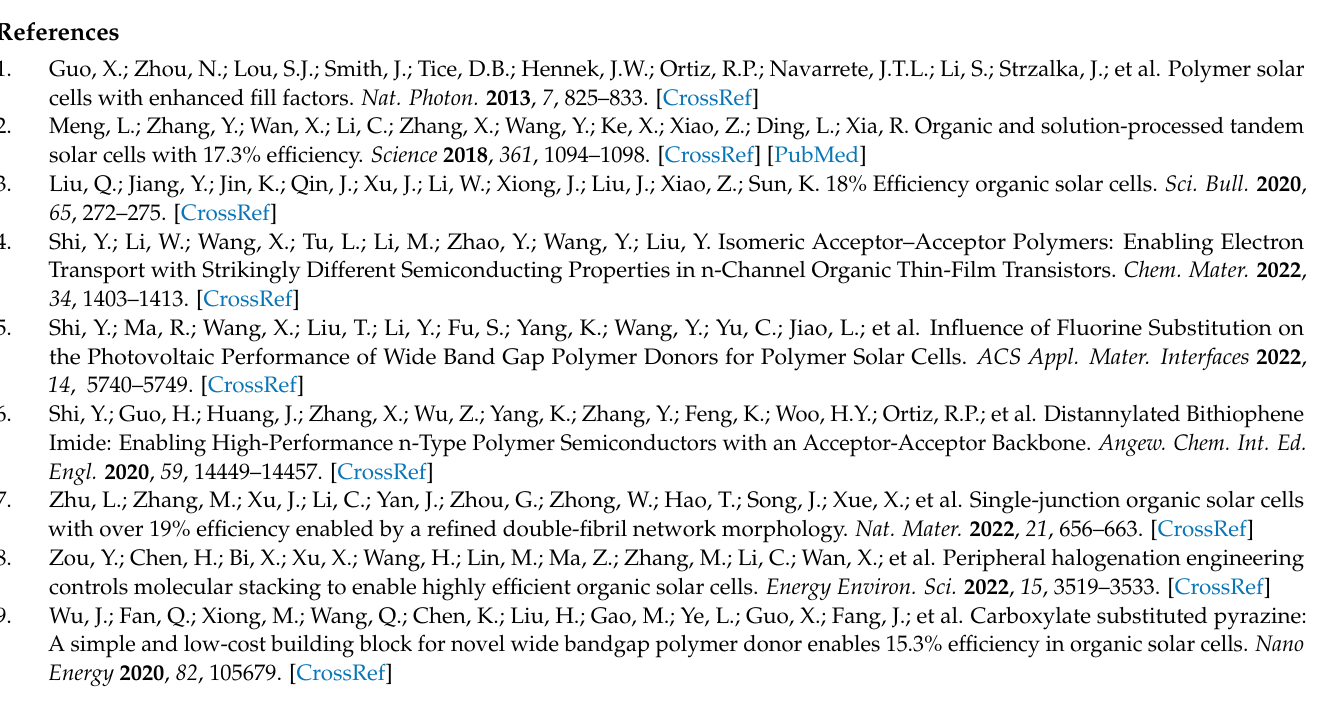
5; Figure S2: 13 C NMR spectrum of compound 5; Figure S3: (a) light intensity dependence of J SC , (b) light intensity dependence of V OC ; Figure S4: (a) The J − V curves and (b) EQE spectra; Figure S5: The J − V curves in dark; Figure S6: X-ray diffraction pattern of P(BPQI-BDT) and P(BPQI-BDTT); Figure S7: SEM of film state of P(BPQI-BDT):Y6 and P(BPQI-BDTT):Y6. Table S1: Photovoltaic parameters of OSCs based on P(BPQI-BDTT):Y6 and